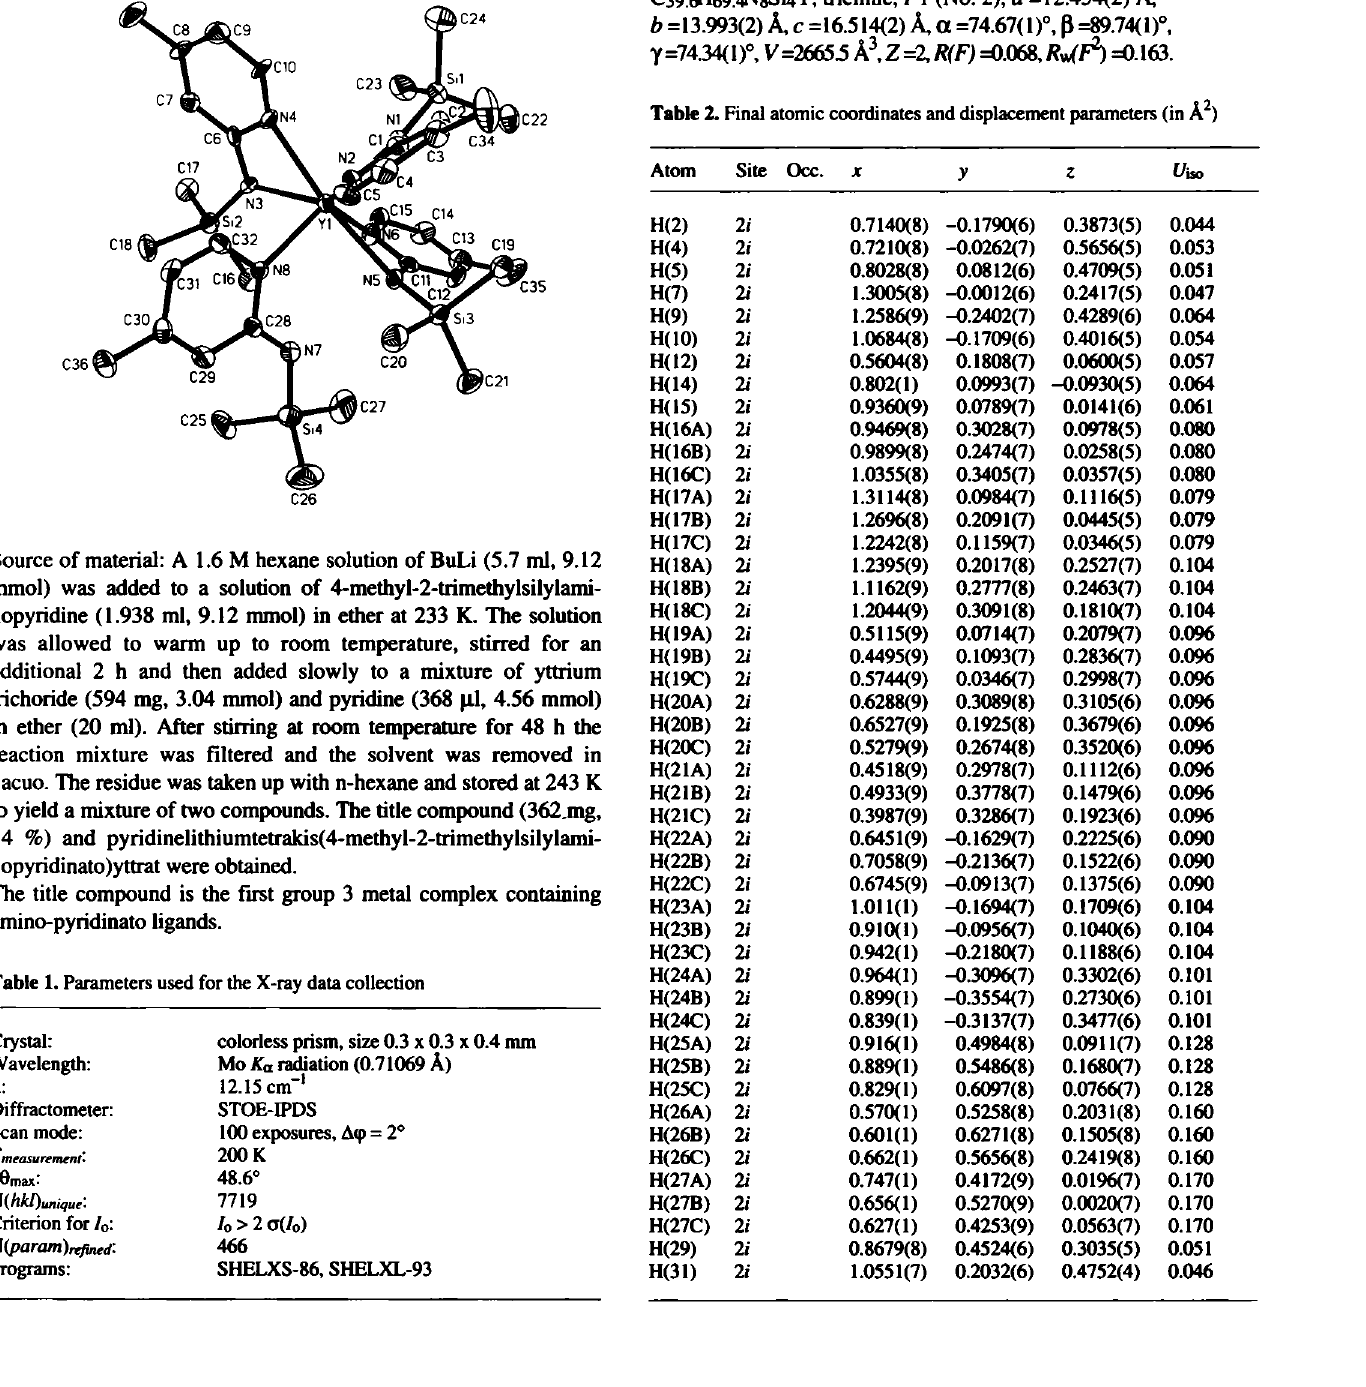
Table 2. Final atomic coordinates and displacement parameters (in Â 2